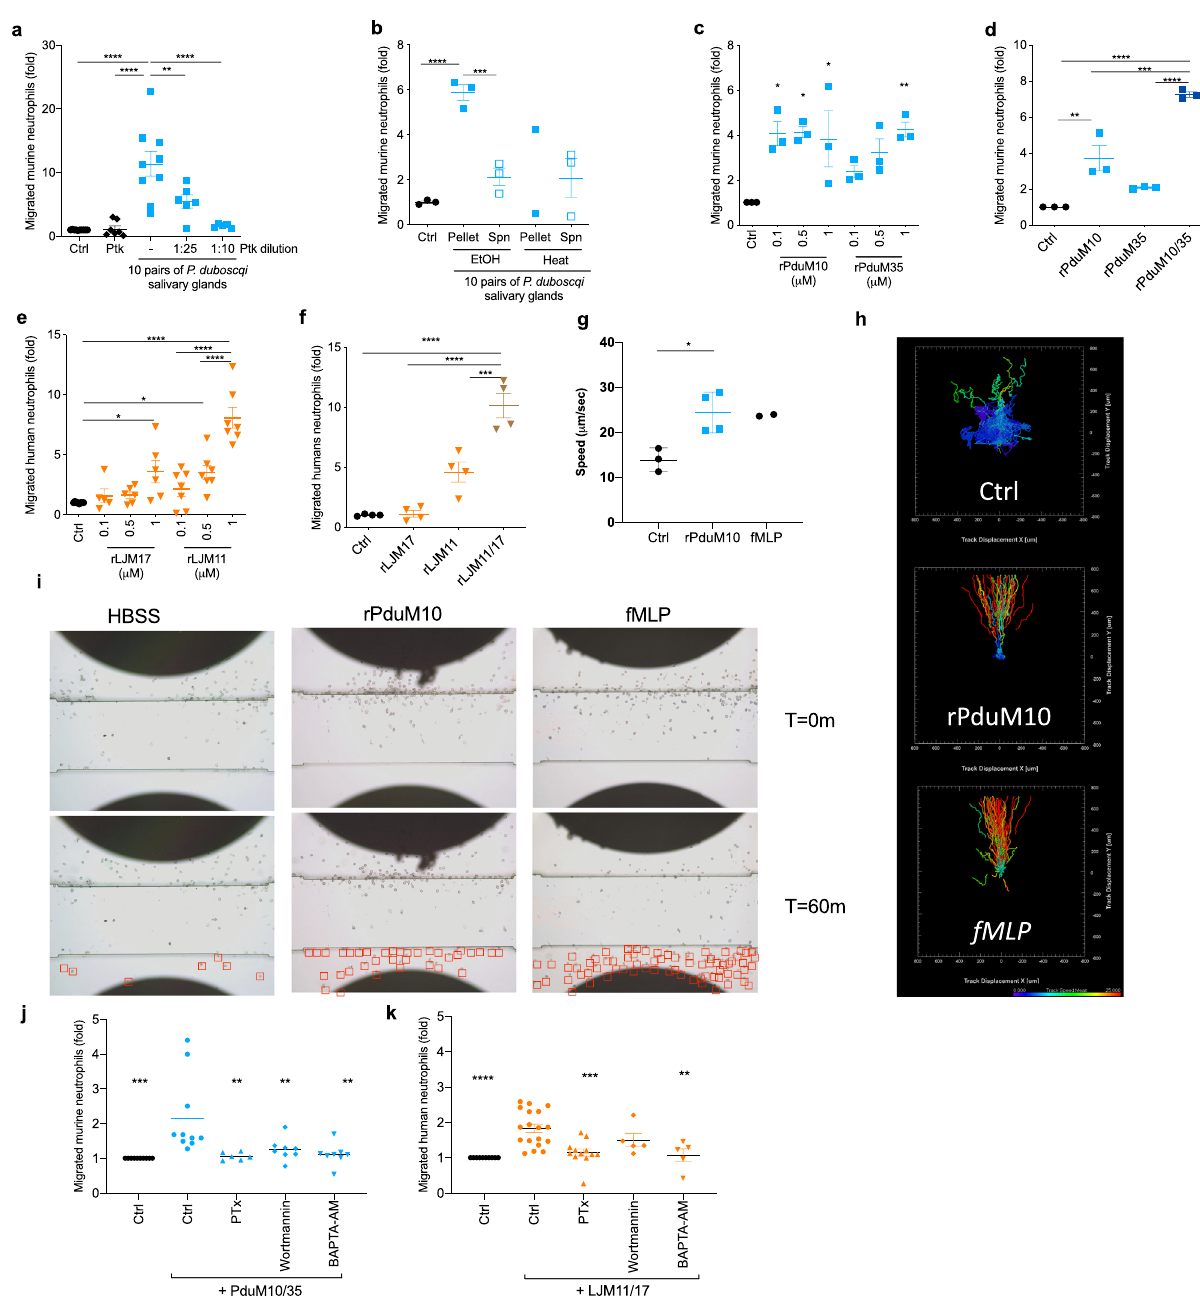
Fig. 2 Sand fl y salivary yellow proteins are the neutrophil chemoattractants in sand fl y saliva. Neutrophils from C57BL6 bone marrow ( a – d , j ) or from human periheral blood ( e , f , k ) were added to a transwell plate top chamber and P. duboscqi salivary gland homogenate (SGH) or recombinant proteins were added to the bottom chamber. After 3 h, cells in the bottom chamber were quanti fi ed. P. duboscqi SGH was treated with Proteinase K (Ptk) ( a ), heated for 30 min at 70 °C ( b ) or treated with 90% of ethanol (EtOH) ( b ). Increasing amounts of rPduM10 or rPduM35 ( c ); rPduM10 (0.5 μ M), rPduM35 (0.5 μ M) or rPduM10 + rPduM35 (0.25 μ M of each protein) ( d ), increasing amounts of rLJM17 or rLJM11 ( e ), or rLJM17 (0.5 μ M), rLJM11 (0.5 μ M) or rLJM17 + rLJM11 (0.25 μ M of each protein) ( f ). g – i Validation of yellow proteins as neutrophil chemoattractants by EZ-TAXIScan assay. N-Formylmethionyl- leucyl-phenylalanine (fMLP) was used as a positive control, and Hanks ’ Balanced Salt Solution (HBSS) as baseline control. g , h Chemotaxis parameters were analyzed by Imaris. g Chemotaxis mean speed was computed as total path length divided by time. h Each track is plotted from the central point showing XY displacement. i Still images of neutrophils at two different time points. Red squares show migrated neutrophils. Neutrophils were pretreated with pertussis toxin (PTx; 2 μ g/mL), wortmannin (1 μ M) or BAPTA-AM (10 μ M) and their migration towards a combination of rPduM10 + rPduM35 ( j ) or rLJM11 + rLJM17 ( k ) (0.25 μ M each) was assayed. Cumulative results of at least three ( a – f , j, k ) or two ( g – i ) independent experiments are presented as means ± SEM; a n = 10, 7, 9, 6, 5; ** P = 0.0043, **** P < 0.0001. b n = 3, 3, 3, 2, 3; *** P = 0.0003, **** P < 0.0001. c n = 3; * P = 0.0123, * P = 0.0104, * P = 0.0208, ** P = 0.0081. d n = 3; ** P = 0.0042, *** P = 0.0007, **** P < 0.0001. e n = 8, 5, 6, 5, 7, 7, 7; * P = 0.0446, ** P = 0.0387, **** P < 0.0001. f n = 4; *** P = 0.0003, **** P < 0.0001. g n = 3, 4, 2; * P = 0.0162. j n = 10, 10, 6, 8, 8; ** P = 0.0032, ** P = 0.0093, ** P = 0.0021 *** P = 0.0003. k n = 10, 18, 12, 5, 5; ** P = 0.0018 *** P = 0.0001, **** P < 0.0001. P calculated by one-way ANOVA test, except ( g ) two-tailed unpaired t